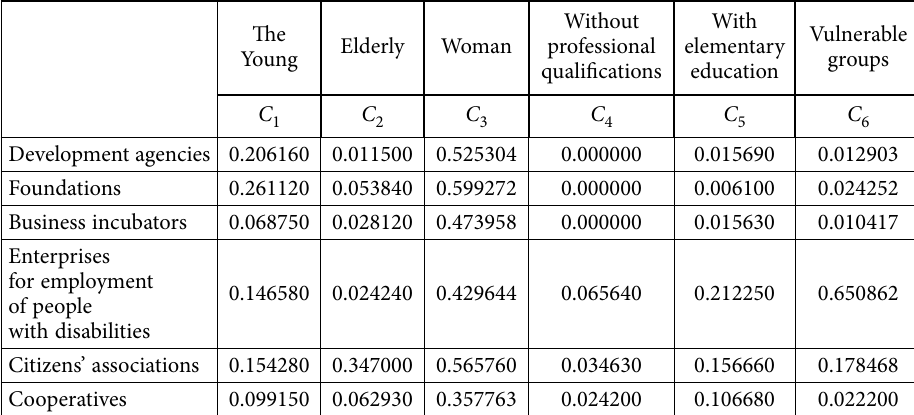
Table 3. Decision matrix for MCDM model (source: authors’ calculations)